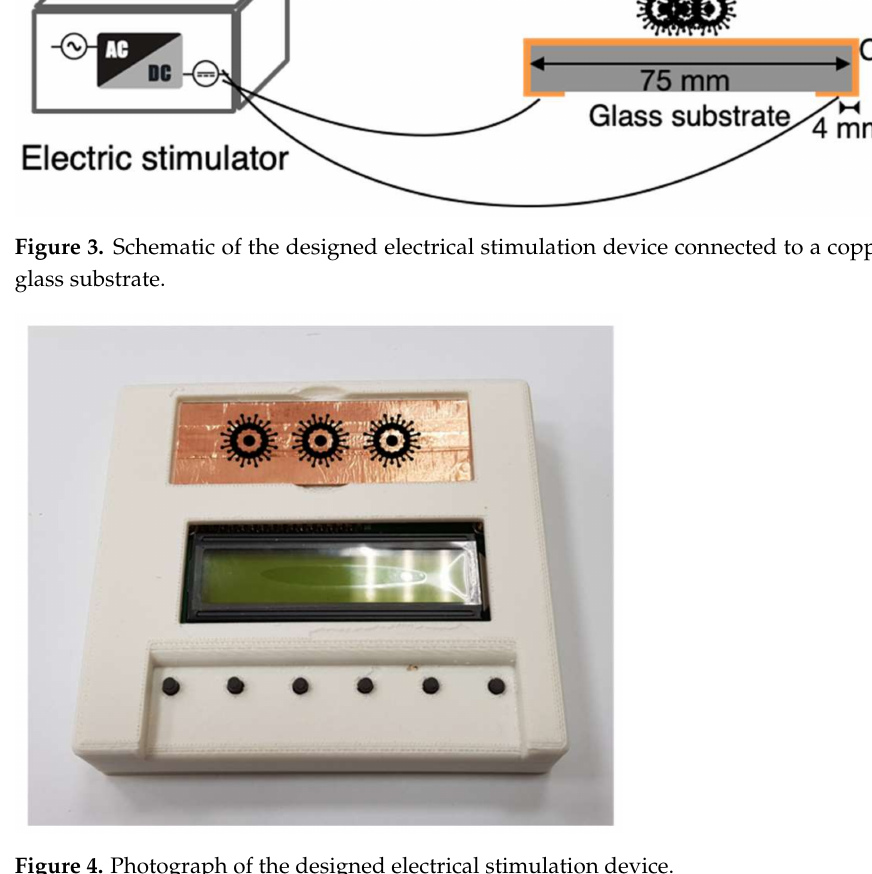
Figure 4. Photograph of the designed electrical stimulation